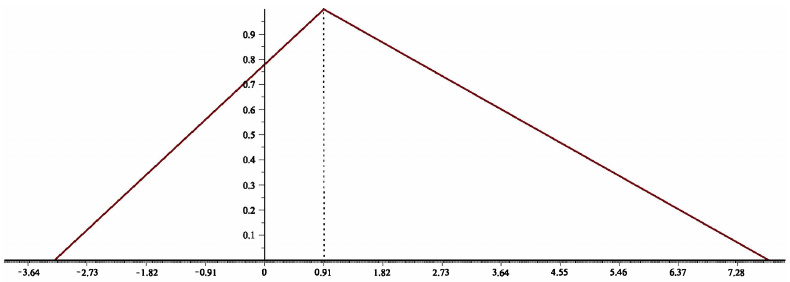
Figure 2. Approximate and analytical solutions of Example